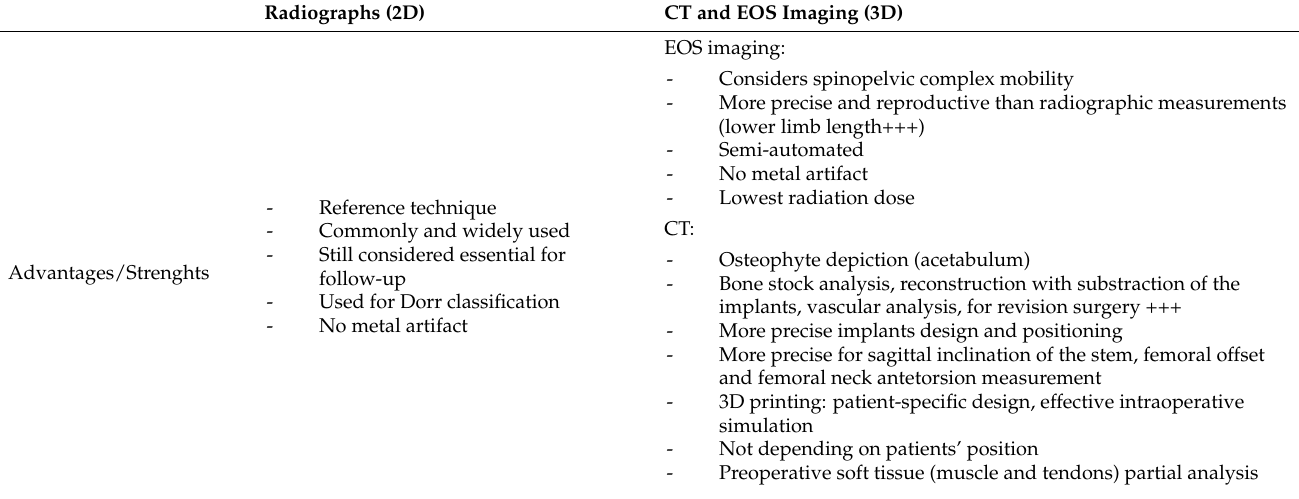
Table 2. Strengths and limitations of 2D and 3D templating imaging